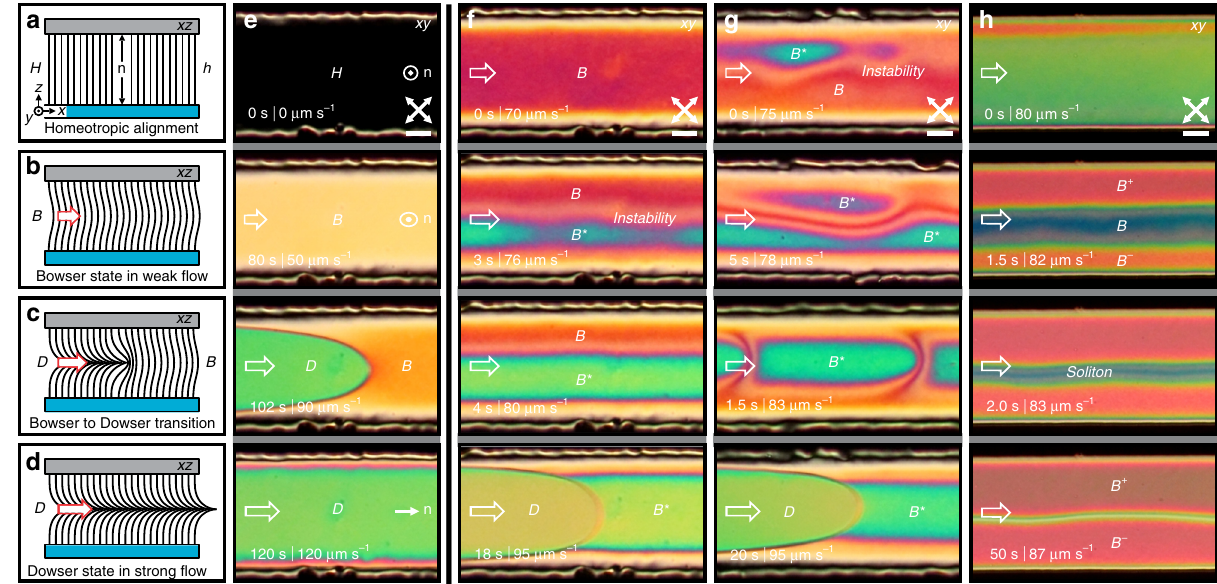
Fig. 1 Orientational phase transitions in pressure-driven nematic fl ows. a Side view of equilibrium homeotropic ( H ) state where the director n is vertically aligned between the top PDMS and bottom glass substrates; h designates the height of a microchannel. b – d The bowed homeotropic – B state – is stable under weak fl ow and undergoes discontinuous transition into the fl ow-aligned – D state – with an increasing fl ow velocity. e A sequence of experimental images shows top view of the B to D state transition. The fl ow acceleration is gradual and relatively slow ( (cid:4) 1 μ m s (cid:1) 2 ). f – h Faster increase of fl ow velocity ( (cid:4) 15 μ m s (cid:1) 2 ) makes the B state locally unstable as it breaks the symmetry into the chiral B (cid:3) state of left- and/or right-handed domains (denoted by B ± to highlight the opposite handedness and by B (cid:3) where handedness cannot be determined from the micrographs). This emergent transition is continuous and fundamentally different from the transition to D state which involves a disclination line between differently oriented regions. A more uniform transition to B (cid:3) state involves the growth of oppositely handed B ± domains from the channel walls, creating a fl exible soliton in the middle. More details of the transition dynamics are shown in Supplementary Figs. 1 and 2. White empty arrows on the left side of panels indicate direction and qualitative fl ow velocity throughout the paper; its approximate value is written in the corners of polarised micrographs. White double arrows show the orientation of the polarizers. Scale bars, 20 μ